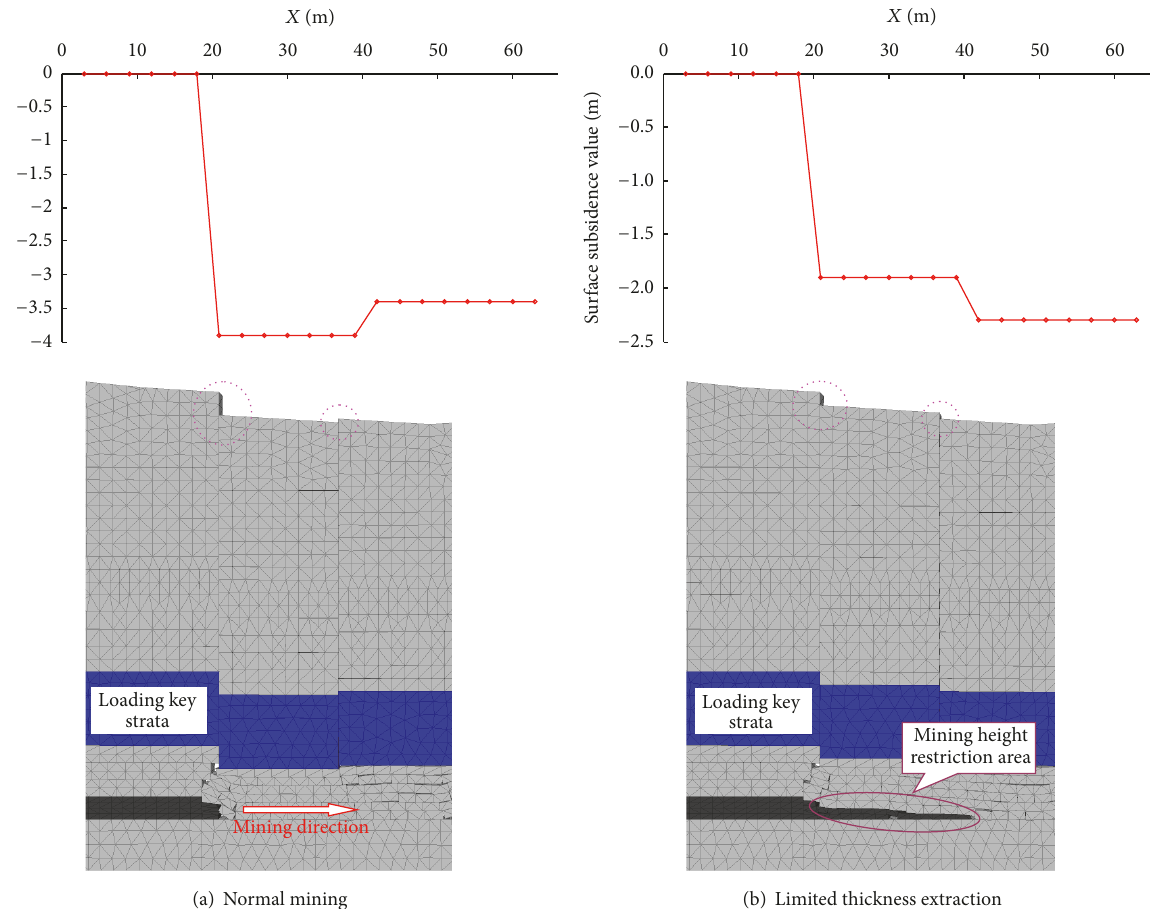
Figure 14: The influence of limited mining height on the morphological development of mining-induced fissures near the beginning line in shallow coal seam